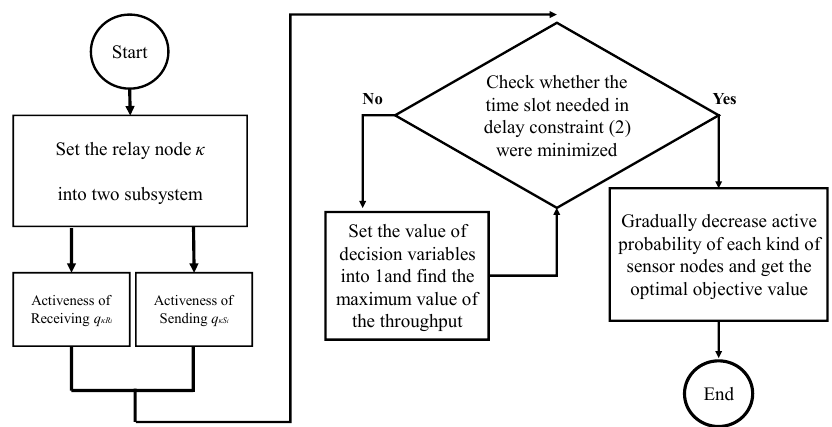
Figure 4. Follow Chart of the Proposed Primal Feasible Solution.